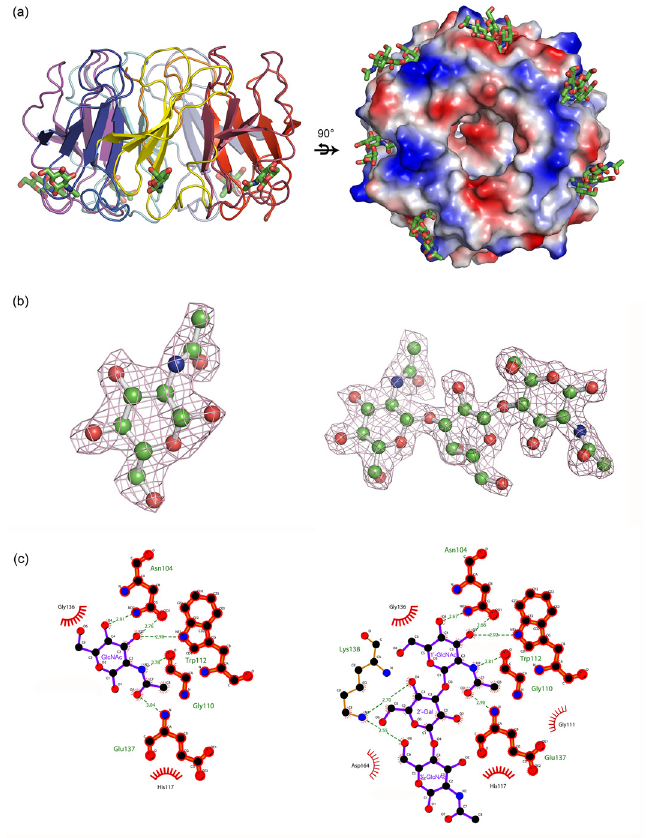
Fig 3. Overview of the six glycan binding pockets of AAL2, alignment of the six GlcNAc molecules and the detailed interaction in WIII. (a) Horizontal view of AAL2-GlcNAc complex (left) and the surface electrostatic potential diagram of the vertical view of AAL2- GlcNAc β 1-3Gal β 1-4GlcNAc complex (right). (b) Sigma-A weighted Fo-Fc omit electron density map around GlcNAc (left) and GlcNAc β 1-3Gal β 1-4GlcNAc (right). (c) The hydrogen bonds and hydrophobic interactions between AAL2 and GlcNAc (left) and GlcNAc β 1-3Gal β 1-4GlcNAc (right), respectively, shown in